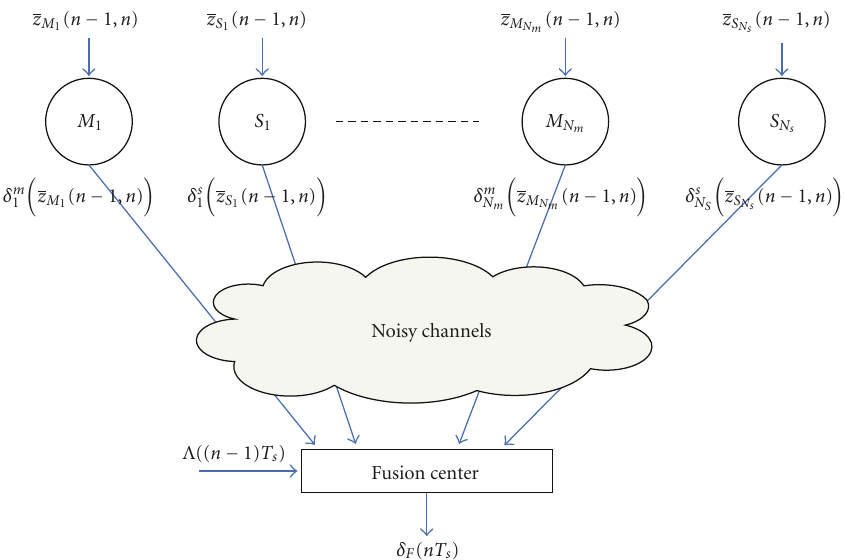
Figure 2: Decision Fusion Architecture for the Hybrid Sensor Network with Fusion Center updating Decisions over Time.